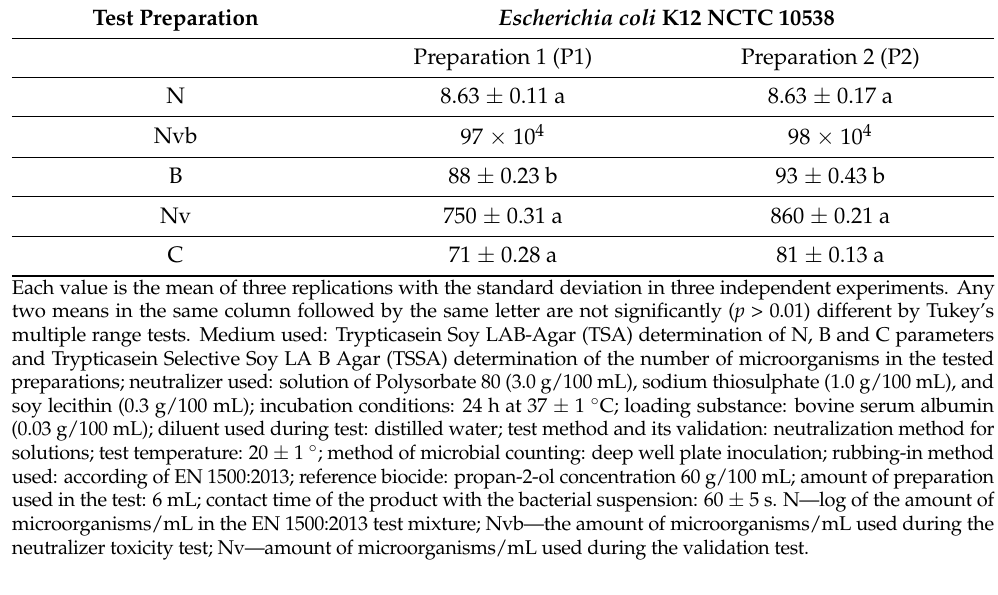
Table 9. Conditions for determining the antimicrobial activity of plant preparations according to the EN 1500:2013 standard. EN 1500:2013 Test